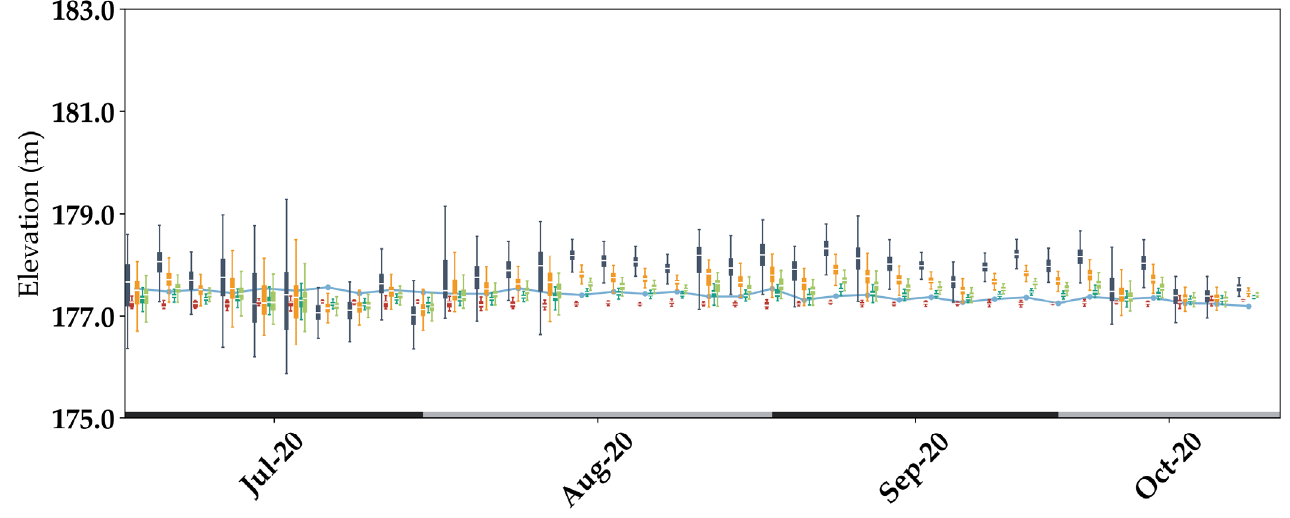
Figure 7. Boxplot by track of the original estimated elevations by GEDI over Lake Huron and the four tested models presented in Sections 3.1.1 and 3.1.2. The blue line represents in situ elevations.